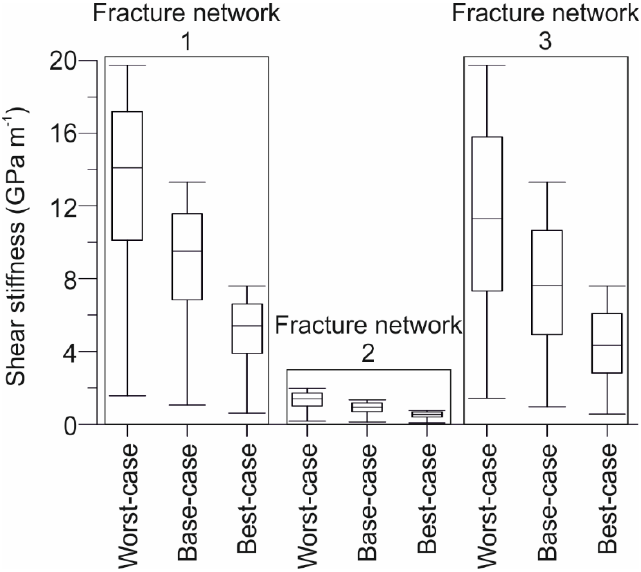
Figure 8. Boxplot of fracture shear stiffness with whiskers from minimum to maximum. The reader